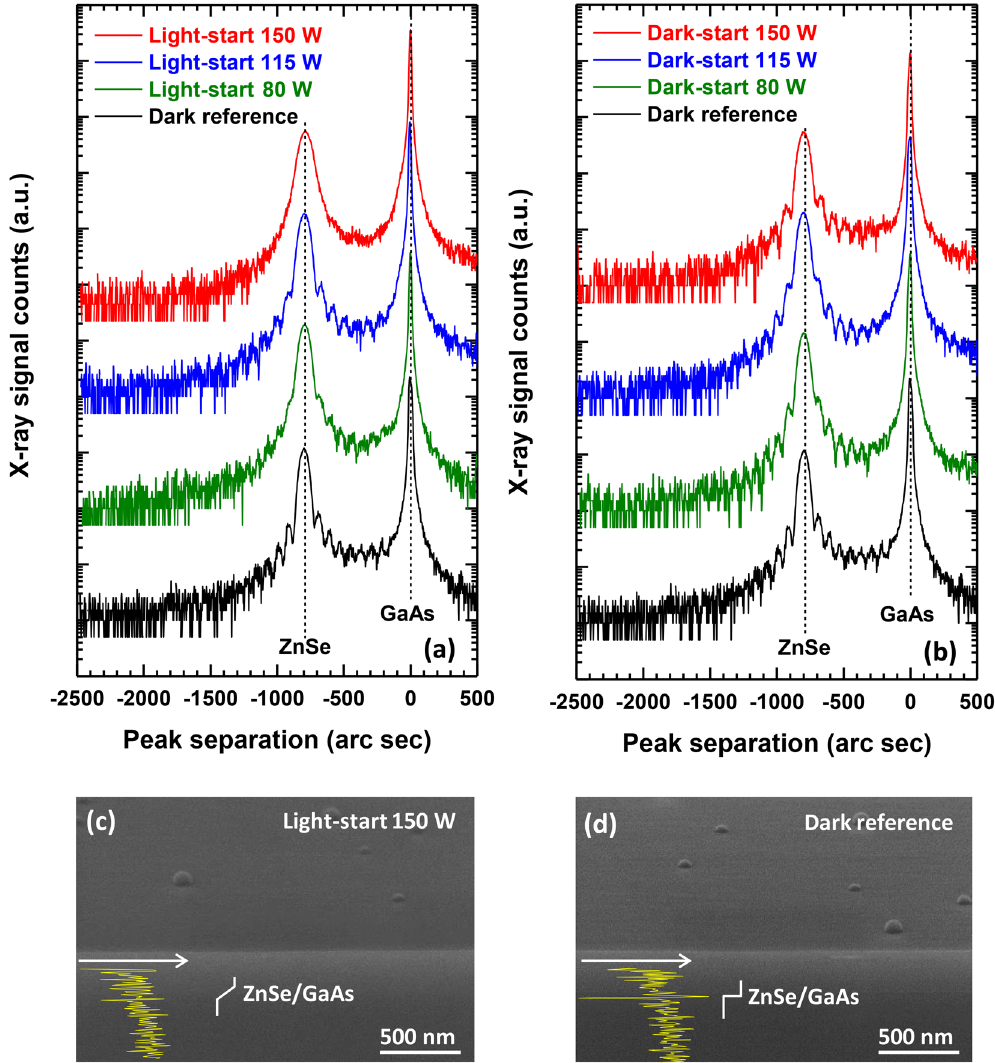
Figure 2. ( a , b ) HRXRD curves of samples grown under light-start and dark-start conditions, respectively. From bottom to top the Xe lamp power increased from 0 W to 150 W. Fringes between the GaAs and ZnSe peaks disappeared with increasing Xe lamp power in the light-start samples, indicating diffusion at the interface. The fringes remained clear in all dark-start samples, indicating the presence of an abrupt interface. ( c , d ) Tilt-view SEM images of the light-start sample grown under a lamp power of 150 W as well as a dark reference sample. The yellow curves display a first derivative of the image contrast profile at the ZnSe/GaAs interface. The contrast profile is sharp at the interface of the dark reference